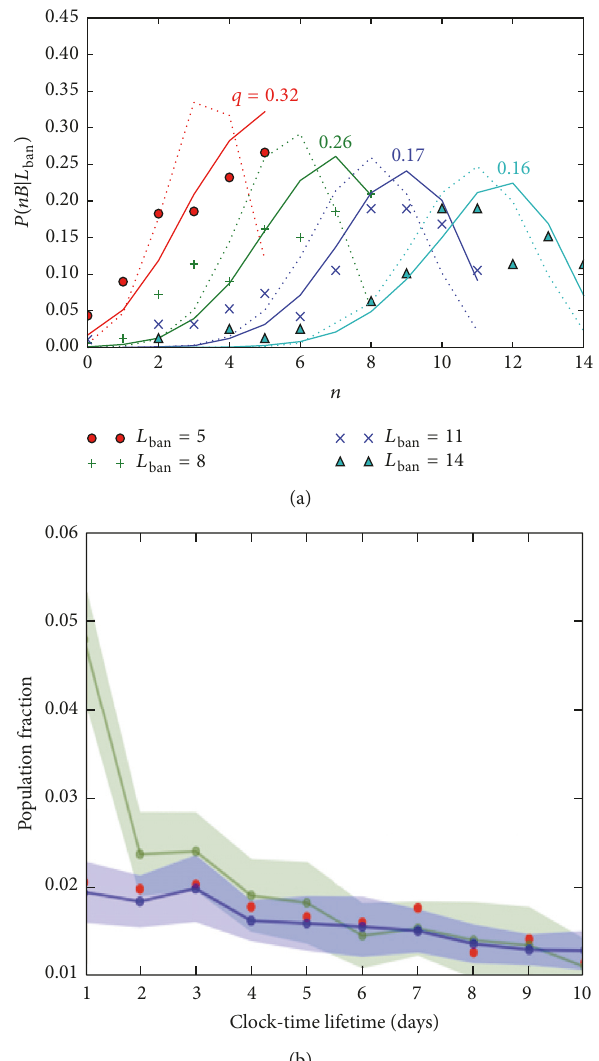
Figure 2: Memory effects for shorter lifetimes . (a) Plot of conditional ) given a specific event-time lifetime expansion terms 𝑃(𝑛𝐵 | 𝐿 ban 𝐿 for individuals who will eventually get banned (i.e., future- ban ) = 𝑃(𝑛𝐵 ∩ 𝐿 )/𝑃(𝐿 ) is the ban individuals). 𝑃(𝑛𝐵 | 𝐿 ban ban ban probability that any given individual in our study (i.e., out of all individuals) will get banned and that he/she joins exactly 𝑛 future- ban ( 𝐵 ) groups prior to this banning, conditioned on his/her event- time lifetime until banning being 𝐿 . By definition, 𝐿 and ban ban ) are undefined for individuals whose accounts hence 𝑃(𝑛𝐵 | 𝐿 ban do not get banned. Scattered points: empirical values obtained from the set of individual pathways in our dataset. Solid lines: our finite memory model with parameter value 𝑞 shown and obtained from a maximum likelihood estimate (MLE). Dotted lines: result for a memoryless null model in which individuals have the same average group-joining rate as the data (obtained using MLE), hence yielding a binomial distribution. The largest memory effects arise for the shortest event-time lifetimes. (b) Comparison of the clock- time lifetime 𝑇 distribution from the empirical data (red dots), ban our mathematical model with memory effects (blue), and without memory effects (green). Error bands are obtained from simulations of the model. 𝑇 is undefined for individuals whose accounts do ban not get banned. The largest memory effect arises for the shortest clock-time